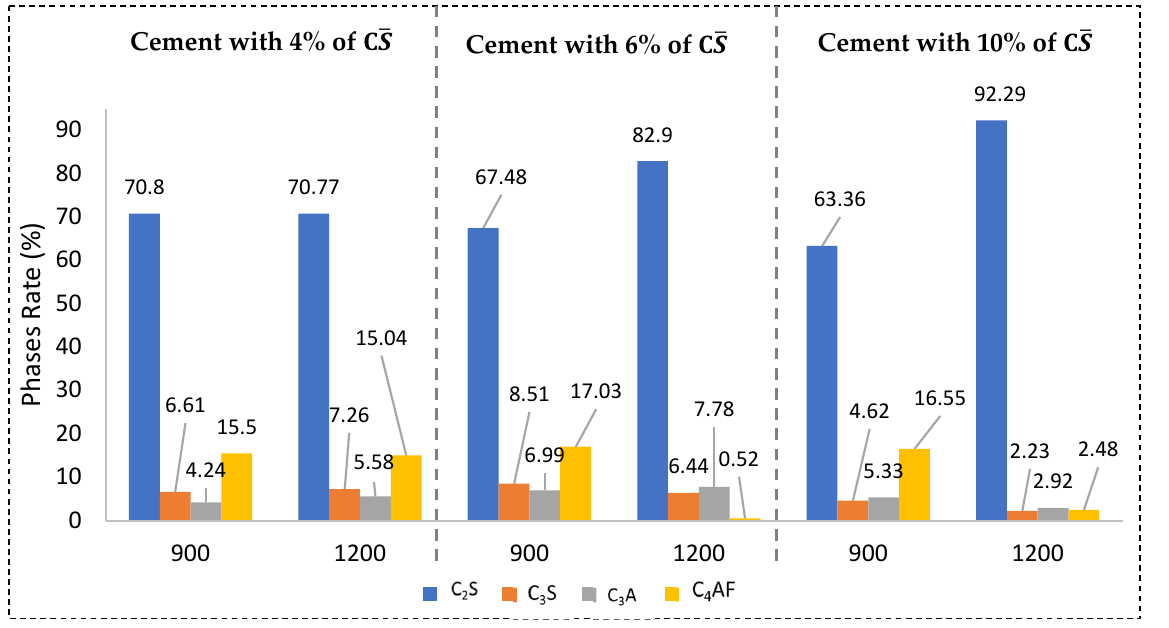
duced a significant amount of C 4 AF. As for the cement produced with 6 and 10% of 𝐶𝑆 the